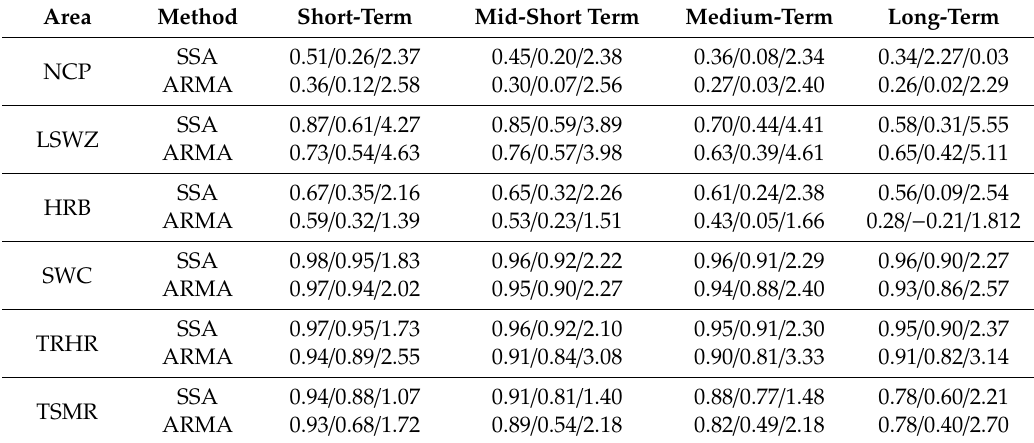
Table 3. Accuracy evaluation of regional TWSA prediction from January 2013 to August 2016.